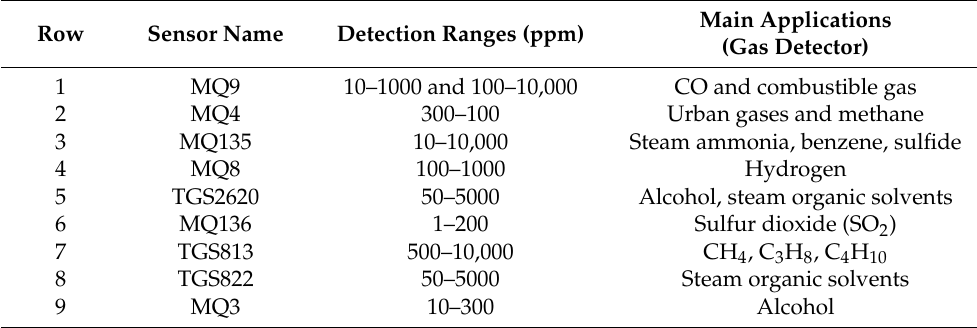
Table 2. The sensor types, gas detection ranges, and known chemical sensitivity of tin oxide MOS sensors within the electronic nose sensor